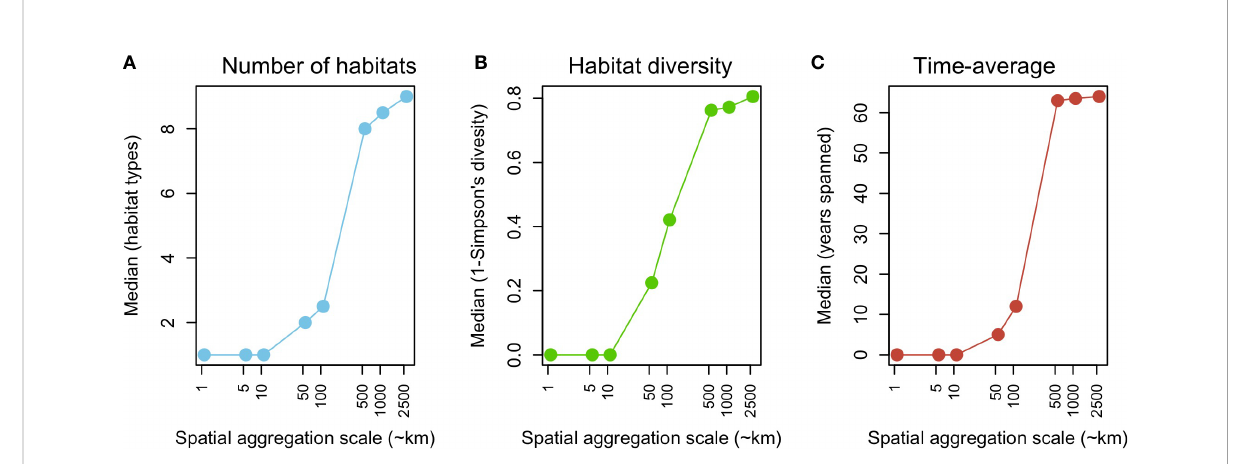
FIGURE 2 Effect of the spatial aggregation scale on (A) the median number of benthic habitats, (B) median diversity of benthic habitats (1-Simpson index), and (C) median time-average (years) of modern